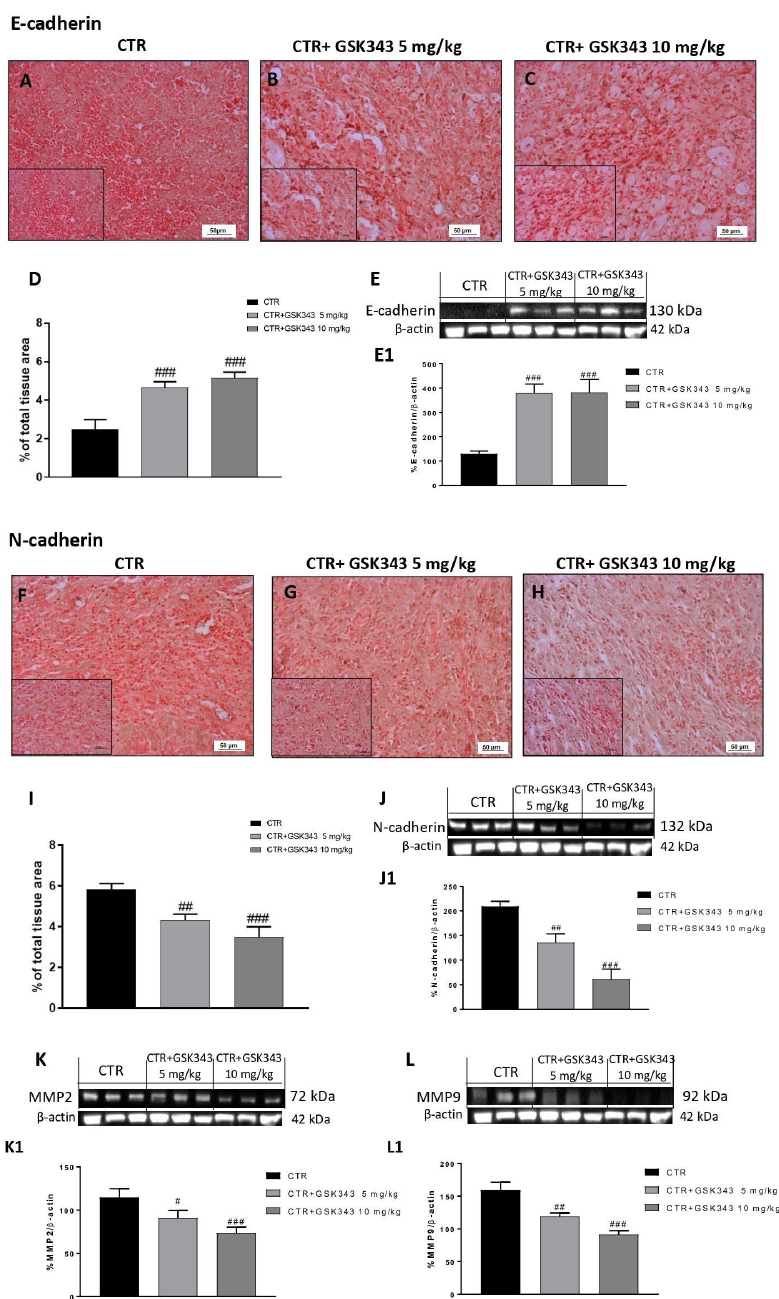
Figure 8. Effect of GSK343 on E-cadherin, N-cadherin, MMP2 and MMP9 expression in the U87- xenograft model. Immunohistochemical analysis revealed that GSK343 at doses of 5 mg/kg and 10 mg/kg significantly increased E-cadherin expression ( B , C ) compared to the control group ( A ). The data for E-cadherin was confirmed also by Western blot analysis ( E ). Furthermore, the treatments with GSK343 at doses of 5 mg/kg and 10 mg/kg ( G , H ) significantly reduced N-cadherin expression compared to the control group ( F ). The data for N-cadherin was also confirmed by Western blot analysis ( J ). The treatments with GSK343 at doses of 5 mg/kg and 10 mg/kg significantly reduced MMP2 and MMP9 expression compared to the control group ( K , L ). Sections were observed and photographed at20x and 40x magnifications. ( D ) ### p < 0.001 vs. Ctr; ( E ) ### p < 0.001 vs. Ctr. ( I ) ## p < 0.01 vs. Ctr; ### p < 0.001 vs. Ctr; ( J ) ## p < 0.01 vs. Ctr; ### p < 0.001 vs. Ctr. ( K ) # p < 0.05 vs. Ctr; ### p < 0.001 vs. Ctr; ( L ) ## p < 0.01 vs. Ctr; ### p < 0.001 vs.